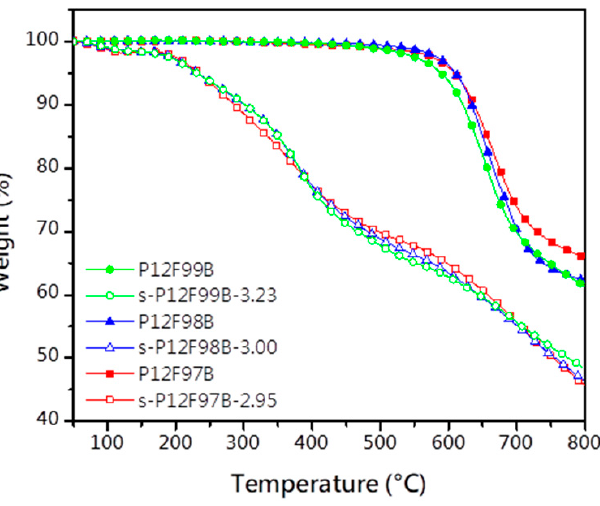
Figure 2. Thermogravimetric analysis curves of the P12FmB polymers and after sulfonation. Table 1. Thermal stability and mechanical properties of the polymers and ionomers.